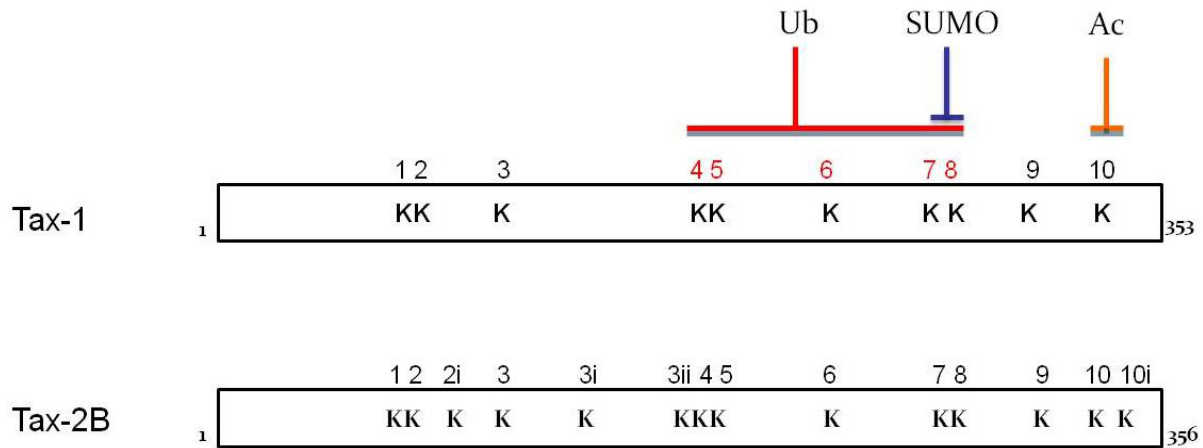
Figure 3. Comparison of Tax-1 and Tax-2 lysine content and modifications. Tax-1